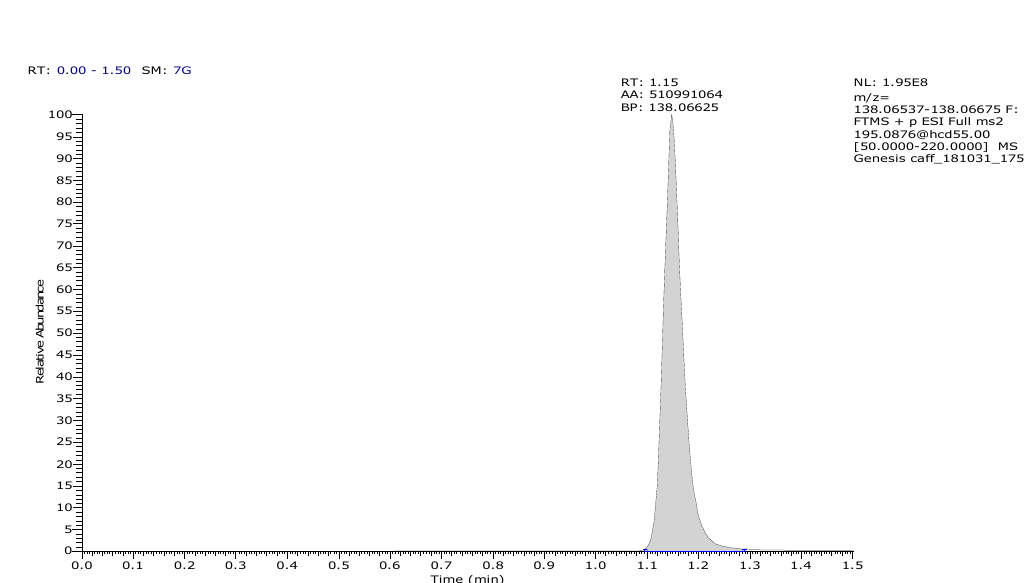
Figure 4. Typical chromatogram of caffeine with the method described in the LC-MS/MS method section.